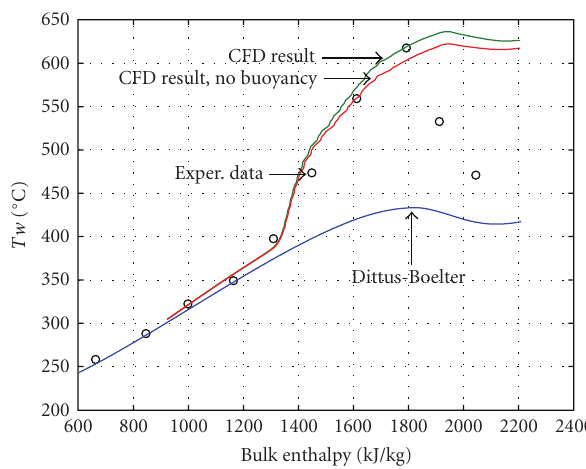
Figure 4: Comparison of the numerical results with the experiment by Ornatskij [3] and the correlation by Dittus-Boelter. Flow conditions: p = 25 . 5 MPa, d = 3mm, G = 1500 kg / m 2 s, q = 1810 kW / m 2 , vertical upward flow in a